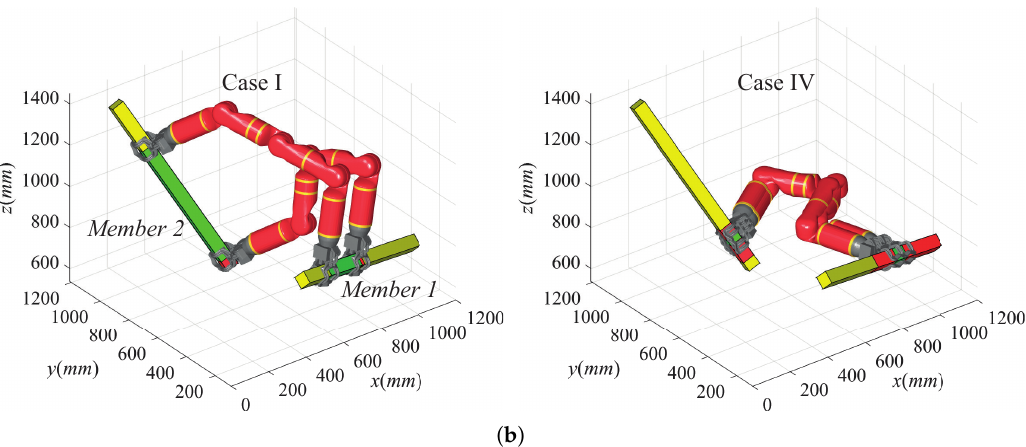
Figure 8. Results of member-to-member transition analysis: ( a ) without the consideration of grip accessibility; ( b ) considering grip accessibility (no operational region for the cases II and III shown in Sub-figure ( a )).